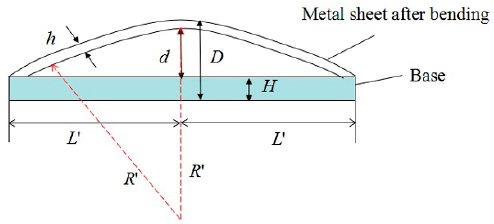
Figure 6. Geometrical schematic of a curvature.